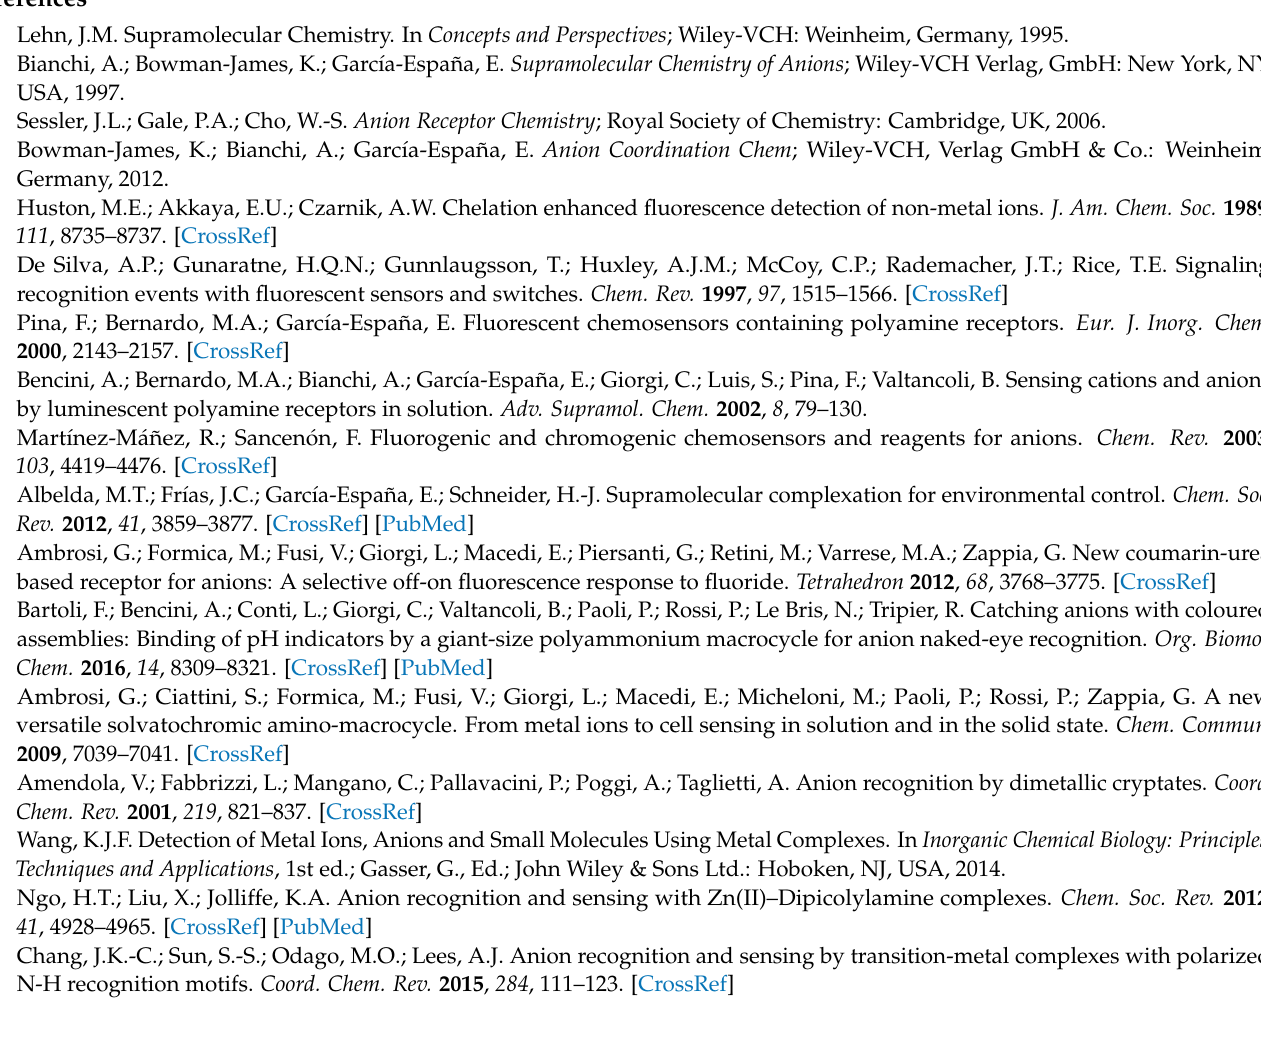
Figure S3: UV-Vis absorption ( a ) and fluorescence ( b ) spectra of L (black line), [Zn L ] 2+ (red line) and [Zn L Cl] + species (blue line) (1.35 × 10 − 5 mol · dm − 3 ; λ ex = 278 nm) in CH 3 CN solution at 298 ± 0.1 K. Figure S4: 1 H-NMR spectra of L (2.0 mM) in D 2 O at pD 6.0, in the presence of increasing equivalents of Zn(ClO 4 ) 2 . Figure S5: Aromatic region of the 1 H-NMR spectra, Figure S6: 1 H-NMR spectra of [ZnL] 2+ (1 × 10 − 2 mol · dm − 3 ) in CD 3 CN at 298 K, in the presence of increasing equivalents of Bu 4 NCl. Figure S7: 1 H − 1 H-COSY ( a ) and 1 H − 13 C HSQC ( b ) NMR spectra of L (1 × 10 − 2 mol · dm − 3 ) in CD 3 CN at 298 K. Figure S8: 1 H − 1 H-COSY ( a ) and 1 H − 1 H-NOESY ( b ) NMR spectra of [Zn L ] 2+ (1 × 10 − 2 mol · dm − 3 ) in CD 3 CN at 298 K. Figure S9: 1 H − 1 H-COSY ( a ), 1 H − 13 C-HSQC ( b ) and 1 H − 1 H-NOESY, and ( c ) NMR spectra of [Zn L Cl] + (1 × 10 − 2 mol · dm − 3 ) in CD 3 CN at 298